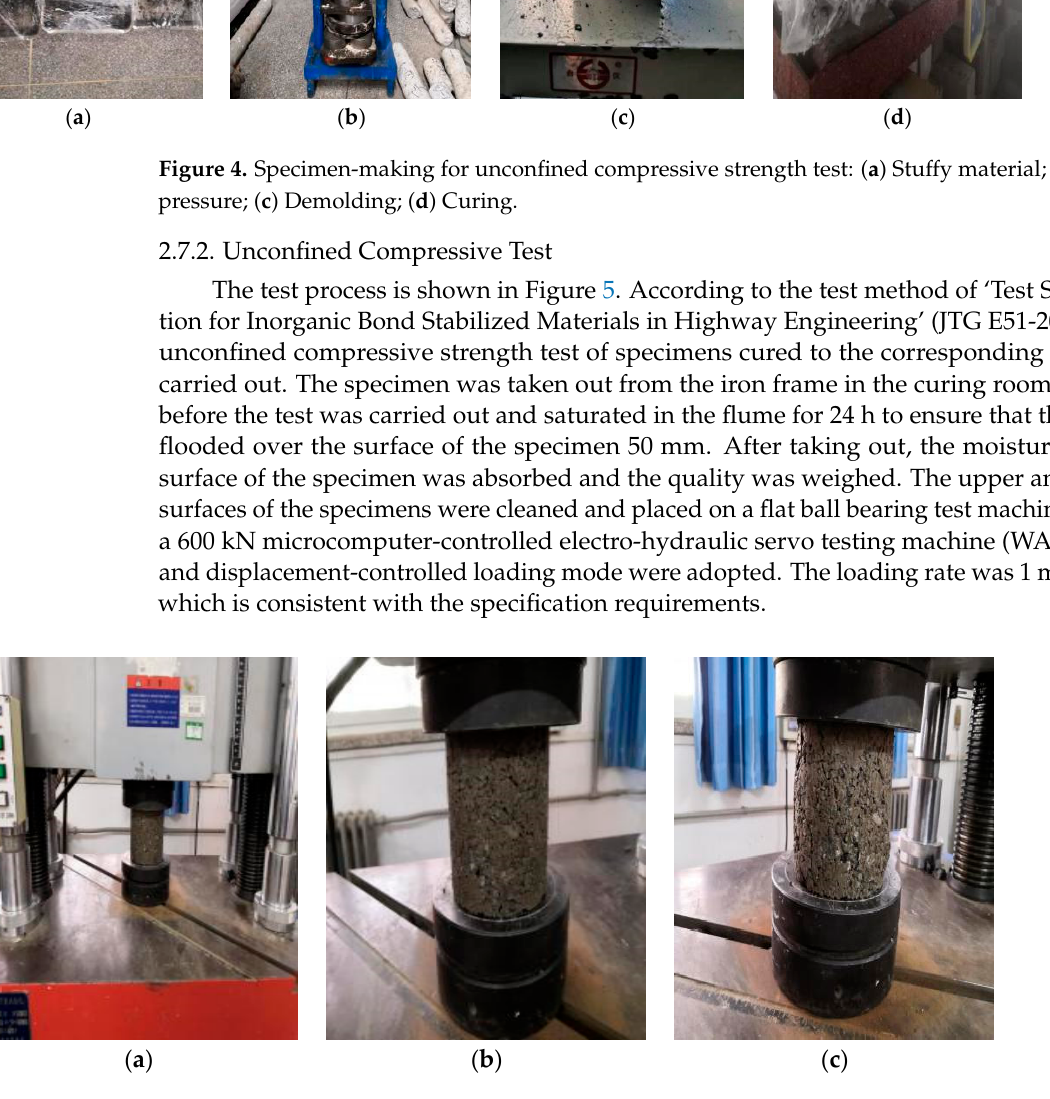
Figure 5. Unconfined compressive strength test: ( a ) Test preparation; ( b ) In test; ( c ) After test.